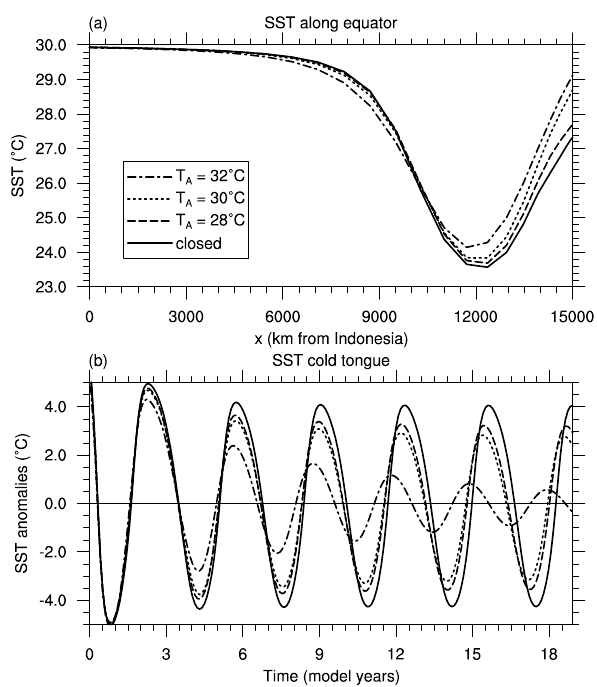
Fig. 6. Effect of an open Panama gateway on the Pacific time- mean zonal SST distribution at the equator and the SST variabil- ity in the cold tongue. The radiation equilibrium temperature and the external wind stress are fixed at T 0 =30 ◦ C and τ 0 = 0 . 01Pa, respectively. (a) Time-mean zonal SST distribution at the equator for three different western Atlantic inflow temperatures T A and the standard case with closed gateway. (b) SST anomalies (in ◦ C) in the cold tongue (minimum SST along the equator) for three differ- ent western Atlantic inflow temperatures T A and the standard case with closed